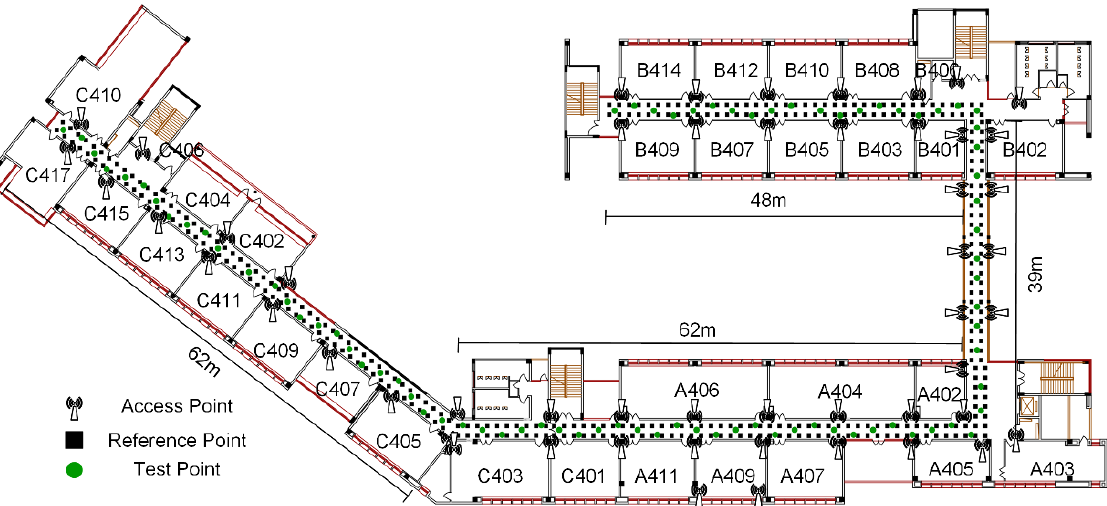
Figure 5. Scenario B. Wireless signal station denotes access point, the reference point is illustrated as a black solid square, and the test point is a green solid circle.